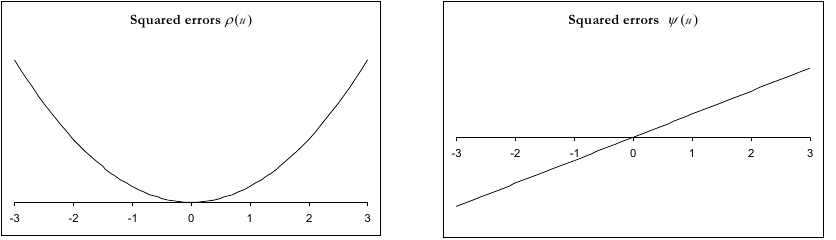
Figure 1 – Squared function (left panel) and the corresponding derivative (right panel).